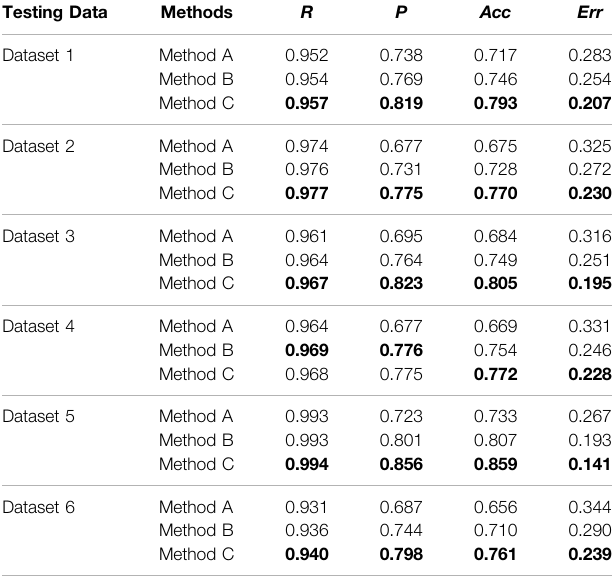
TABLE 5 | Detection Performance Comparison between the Three Methods in case 3. The bold values mean the best detection performance among the three detection methods (Method A, Method B, and Method C).